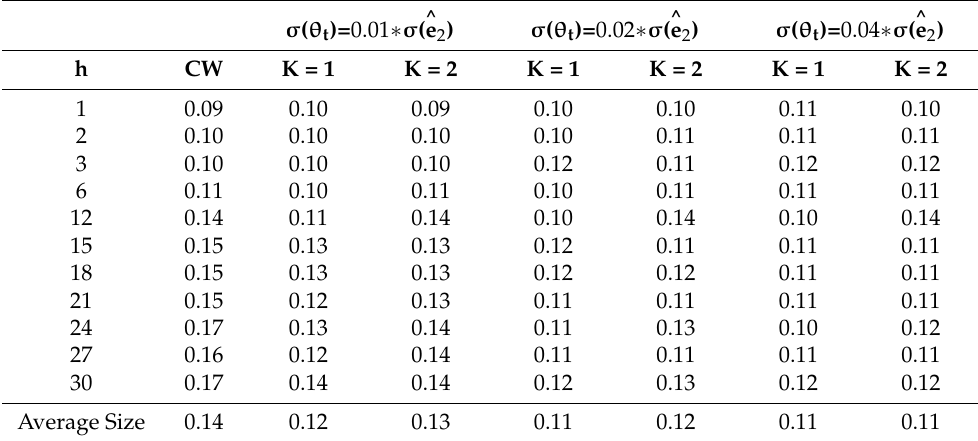
Table 4. Empirical size comparisons between CW and WCW tests with nominal size of 10%, consid- ering DGP2 and a small